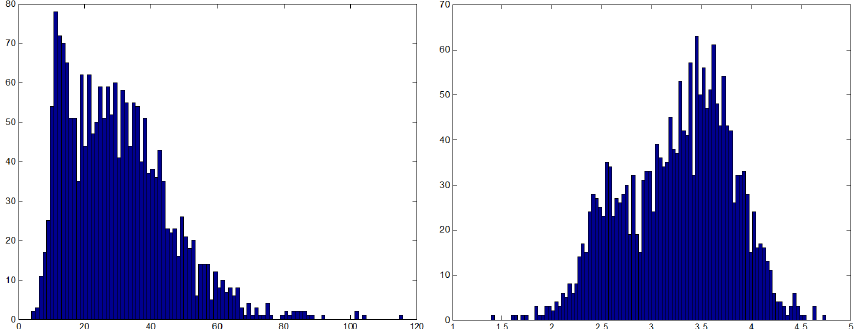
Figure 6. Left panel: distribution of average rainfall over all sites in the western US. Right panel: distribution of average rainfall after transformation. Table 1. Potential features used for statistical downscaling of